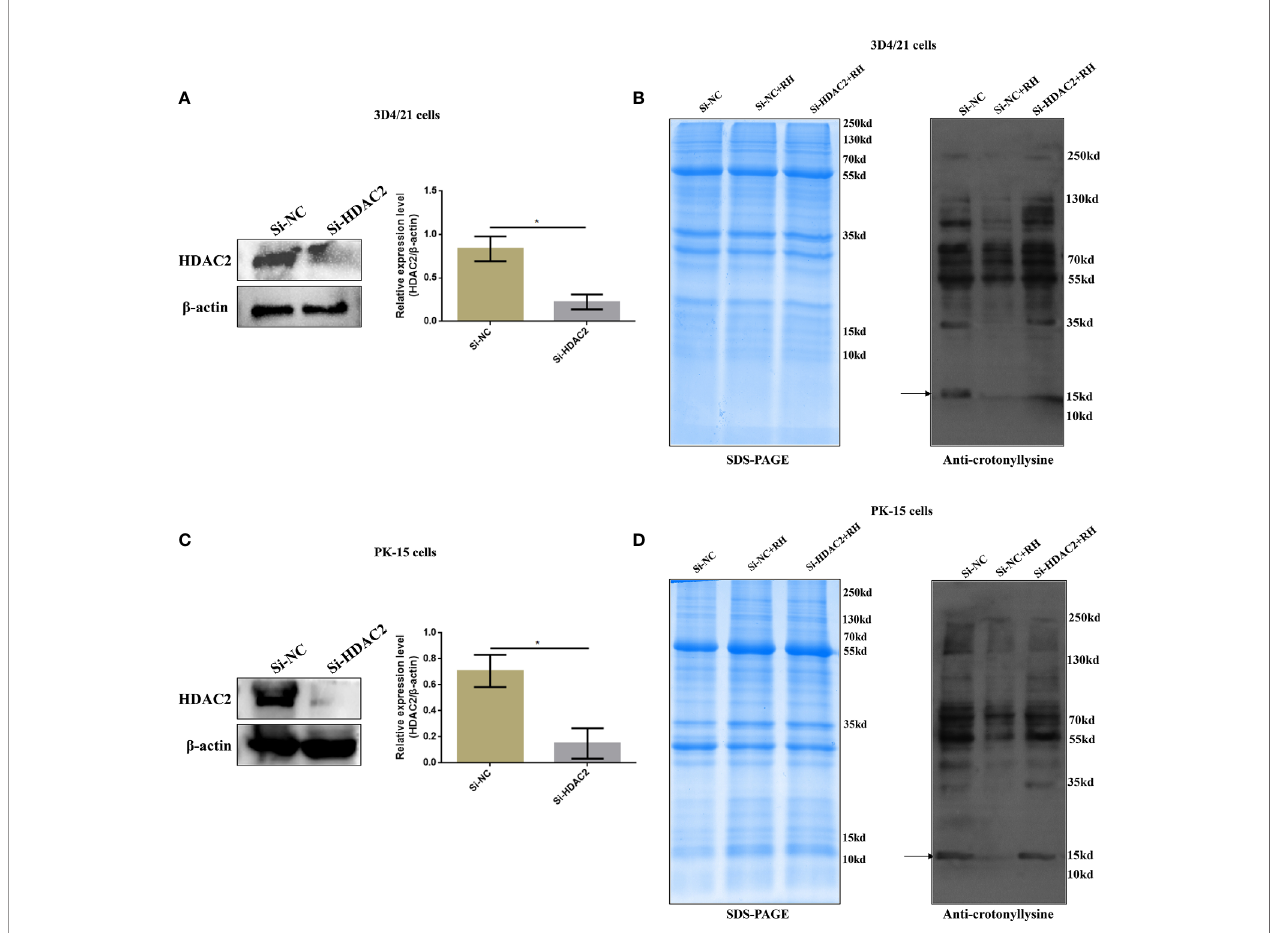
FIGURE 6 | Effects of HDAC2 on crotonylation in porcine alveolar macrophages and PK-15 cells. (A) Western blot analysis of the expression levels of HDAC2 in Si- NC and Si-HDAC2 of 3D4/21 cells. (B) Western blot analysis showing the in fl uence of HDAC2 knockdown on Kcr proteins levels in porcine alveolar macrophages. (C) Western blot analysis of the expression levels of HDAC2 in Si-NC and Si-HDAC2 of PK-15 cells. (D) Western blot analysis showing the in fl uence of HDAC2 knockdown on Kcr proteins levels in PK-15 cells. *p < 0.05, Student ’ s t